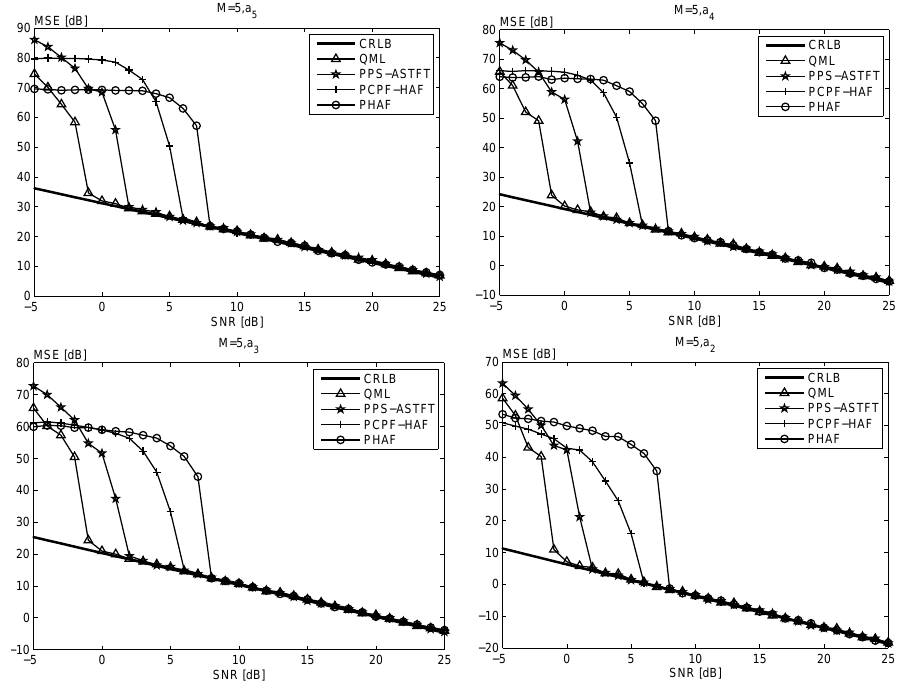
Figure 1. The MSE of the four highest order coefficients of the 5th-order